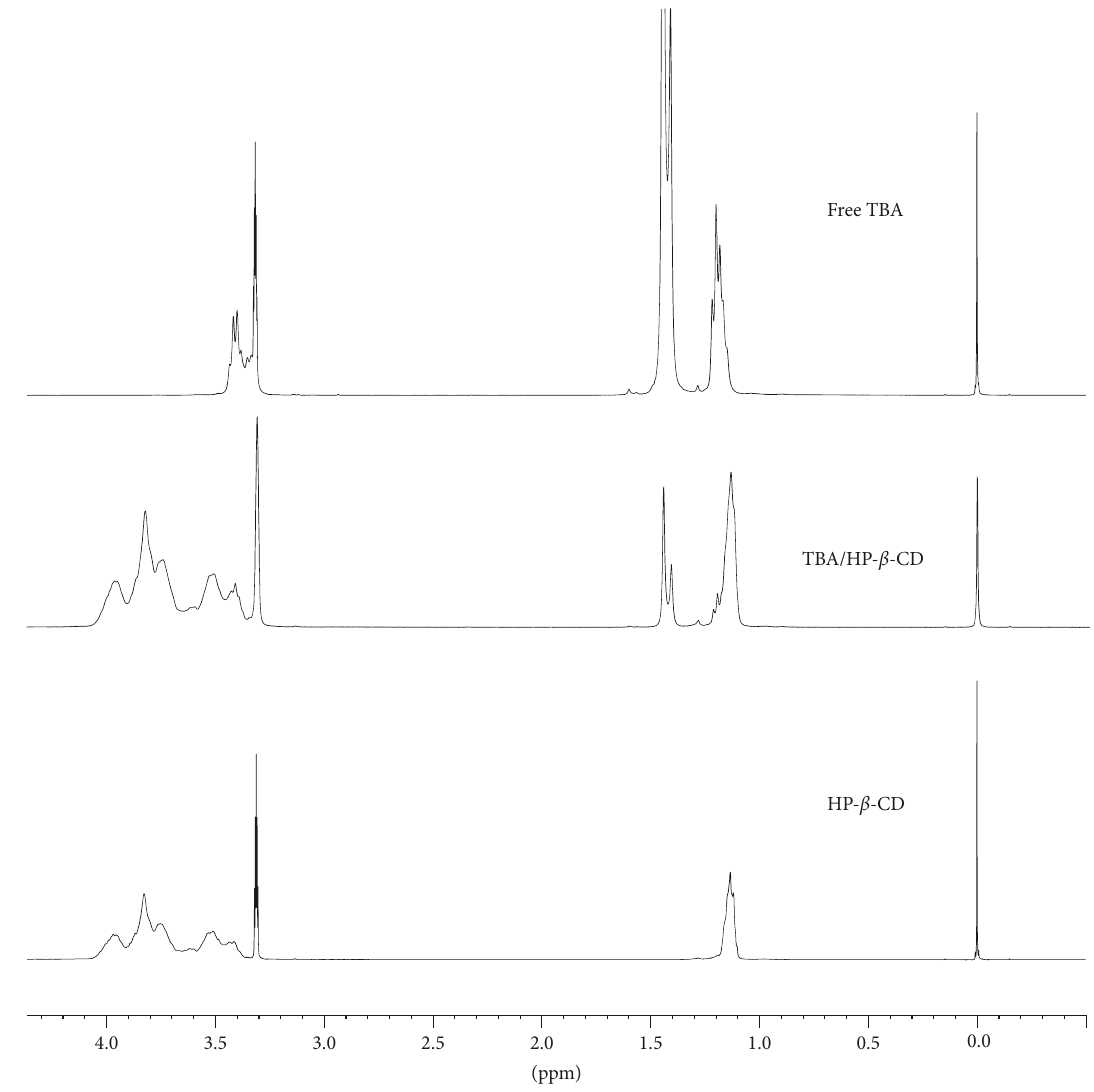
Figure 7: 1 H NMR spectra of TBA, HP- 𝛽 -CD, and TBA/HP- 𝛽 -CD complex in an 8: 1 (v:v) mixture of CD 3 OD and CDCl 3 .